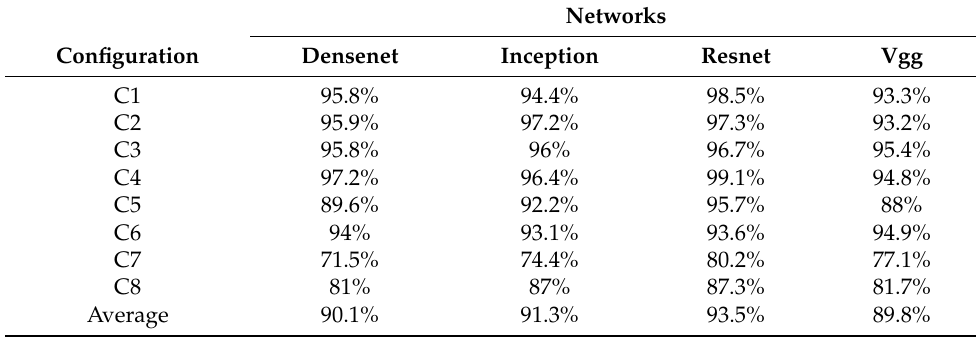
Table 8. Classification accuracy after ROC analysis.